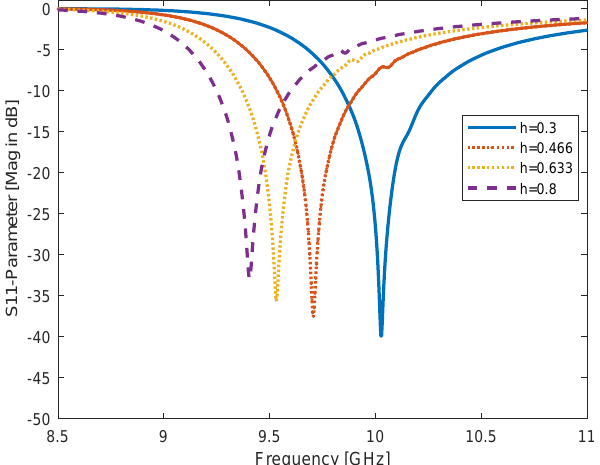
Figure 8. Alteration of both CSRR rings (upper and lower loops) vertical separation, x parameter for x = 0.25, 0.5, 0.75, and 1 mm, and resonant frequency is shifted to the left according to the coupling effect.